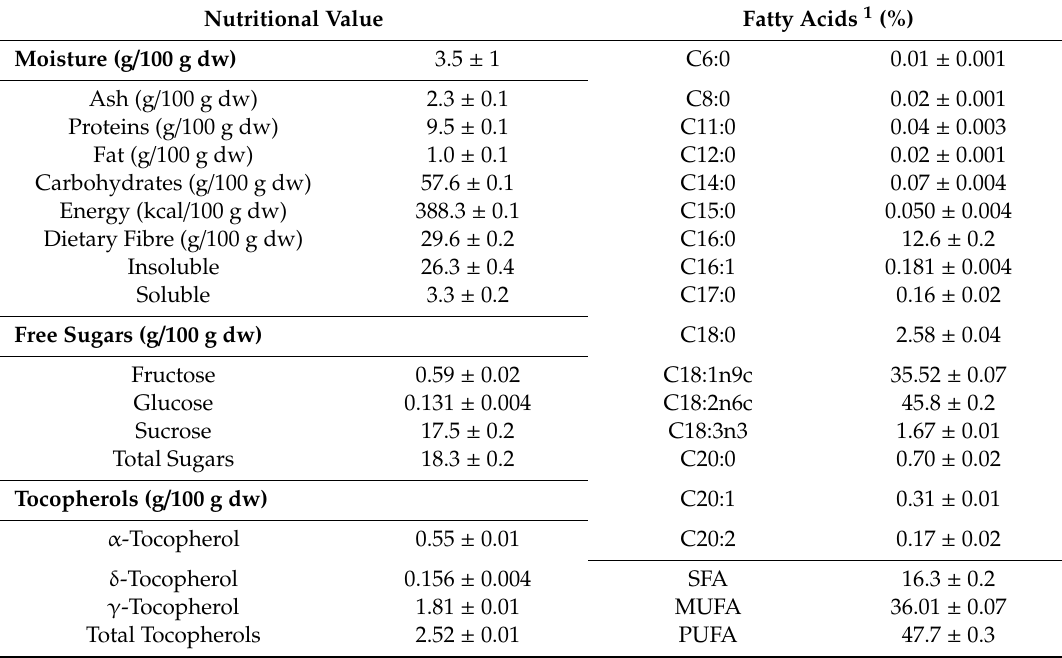
Table 1. Nutritional composition of Prosopis pallida flour derived from mature pod expressed in dry weight basis (mean ±